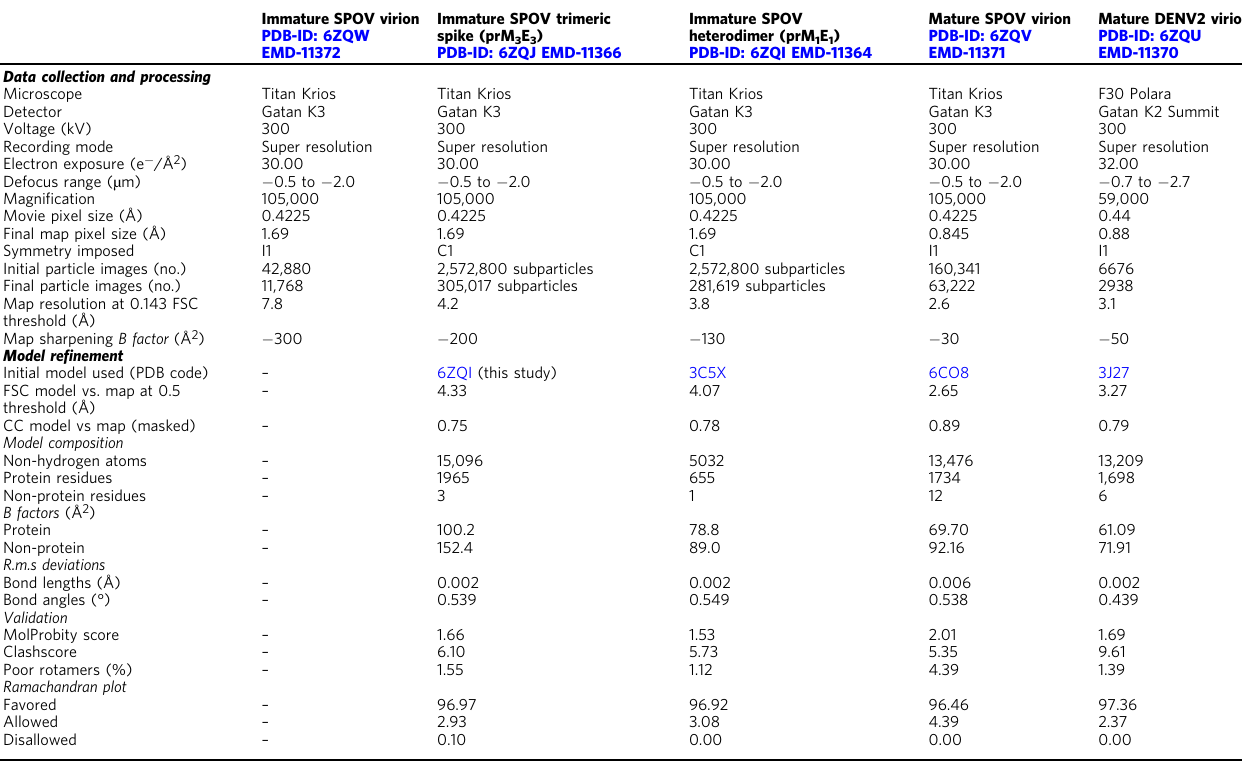
Table 1 Cryo-EM data collection, processing, and model re fi nement statistics.